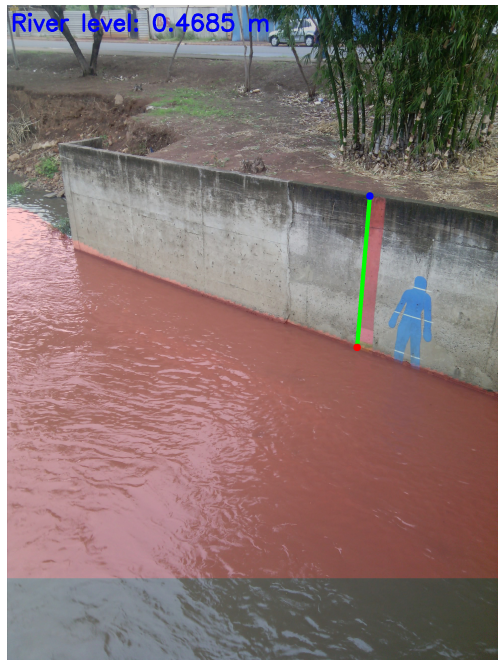
Figure 4. River level detection aided by the DeepLabv3 DNN